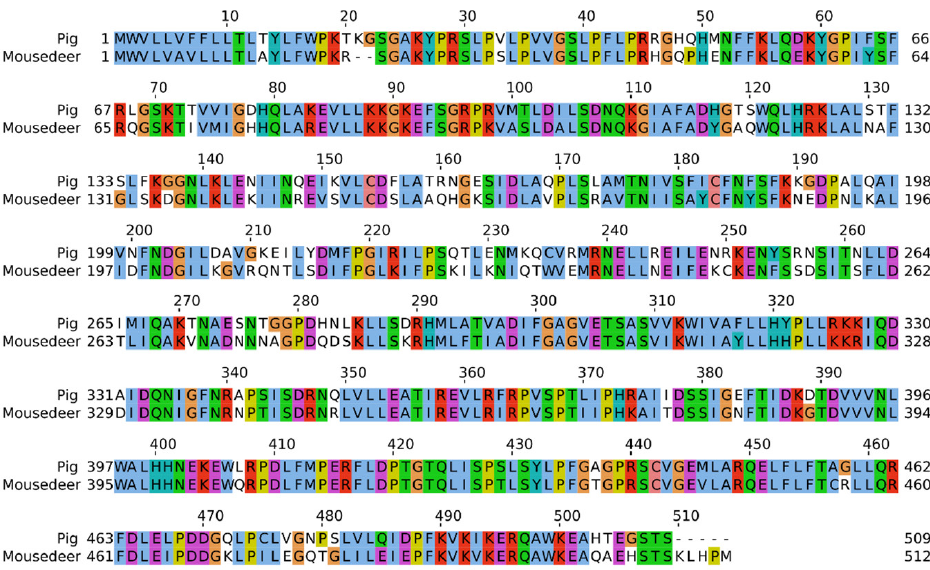
Figure 3. The comparison of deduced amino acid sequence of CYP17A1 between mouse deer and pig. The homologous sequences between mouser deer and pig are highlighted.